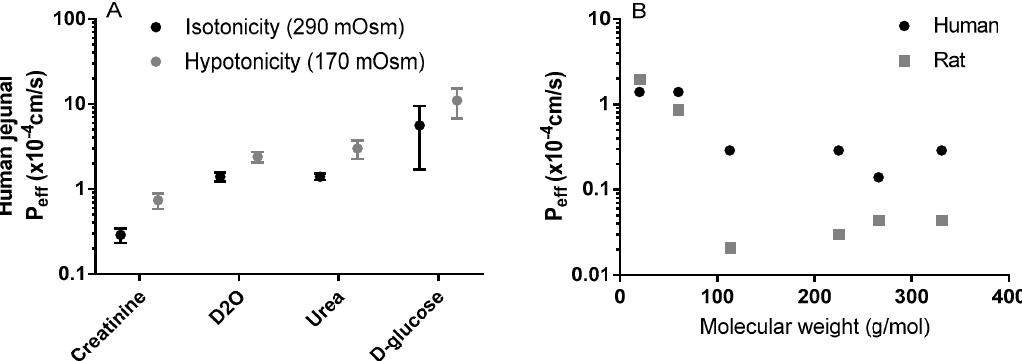
Figure 4. ( A ) The influence of luminal tonicity on the effective permeability (P eff ) of human jejunum to four model compounds with different molecular masses: D 2 O 20 g/mol, urea 60 g/mol, creatinine 113 g/mol, and D-glucose 180 g/mol [58]; ( B ) The influence of the molecular mass of six passively absorbed compounds on the human and rat jejunal P eff values: D 2 O 20 g/mol, urea 60 g/mol, creatinine 113 g/mol, terbutaline 225 g/mol, atenolol 266 g/mol, furosemide 331 g/mol [58]. Figures are remade based on historical data.